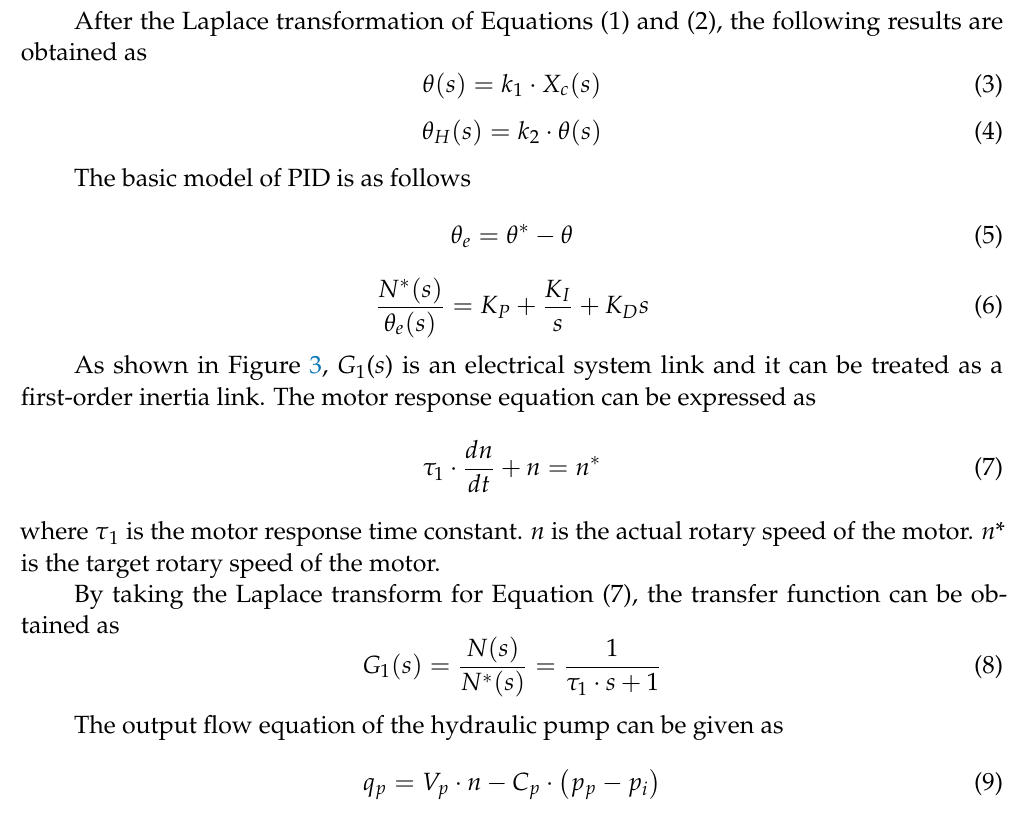
Figure 4. Angle closed-loop control block diagram.